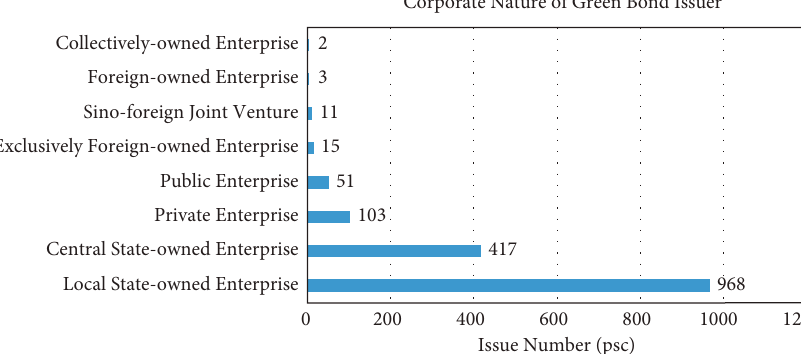
Figure 4: Nature of China’s Green Bond Issuer (Data source: wind, compiled by the